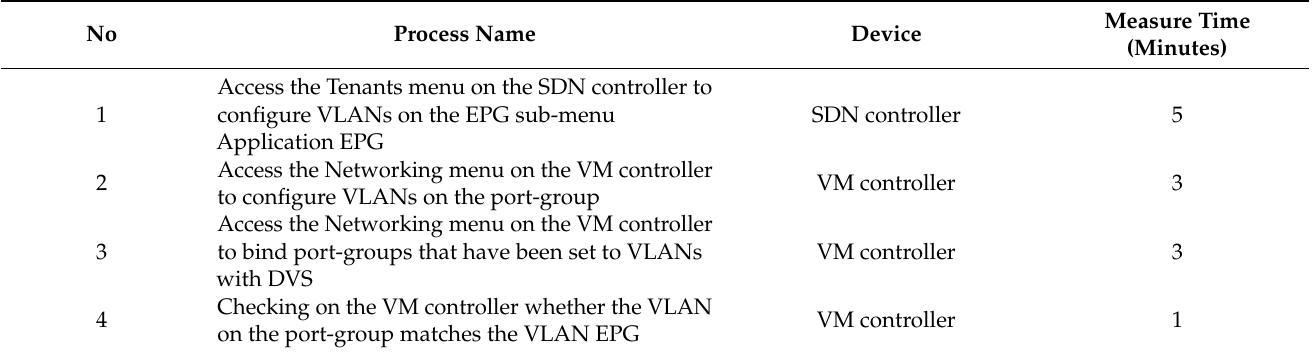
Table 14. Manually adding EPG and port-group measurement